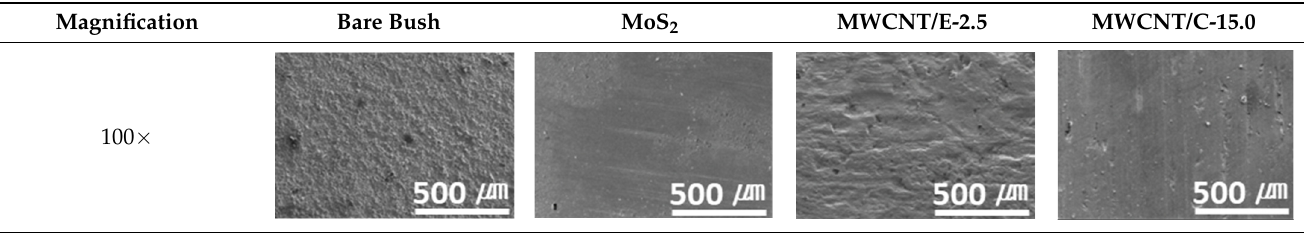
Table 6. Roughness evaluation before and after bush wear according to the addition of MoS 2 and MWCNTs.